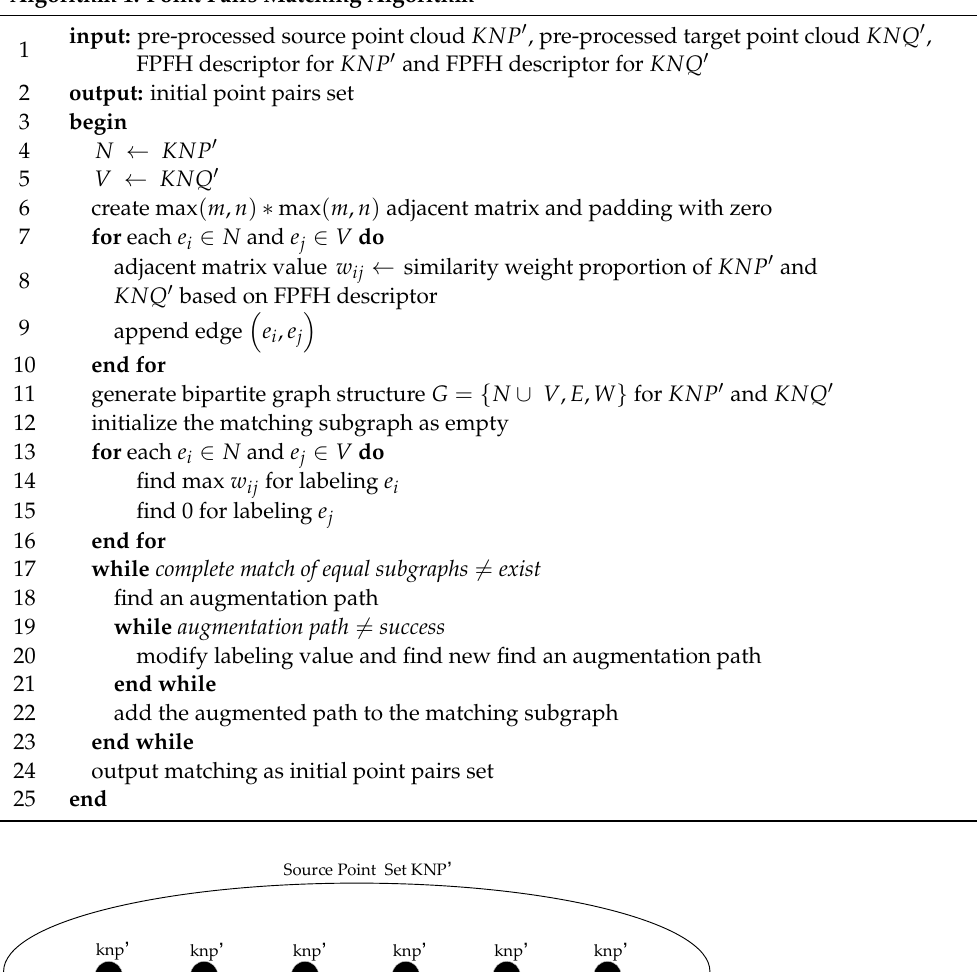
Algorithm 1. Point Pairs Matching Algorithm